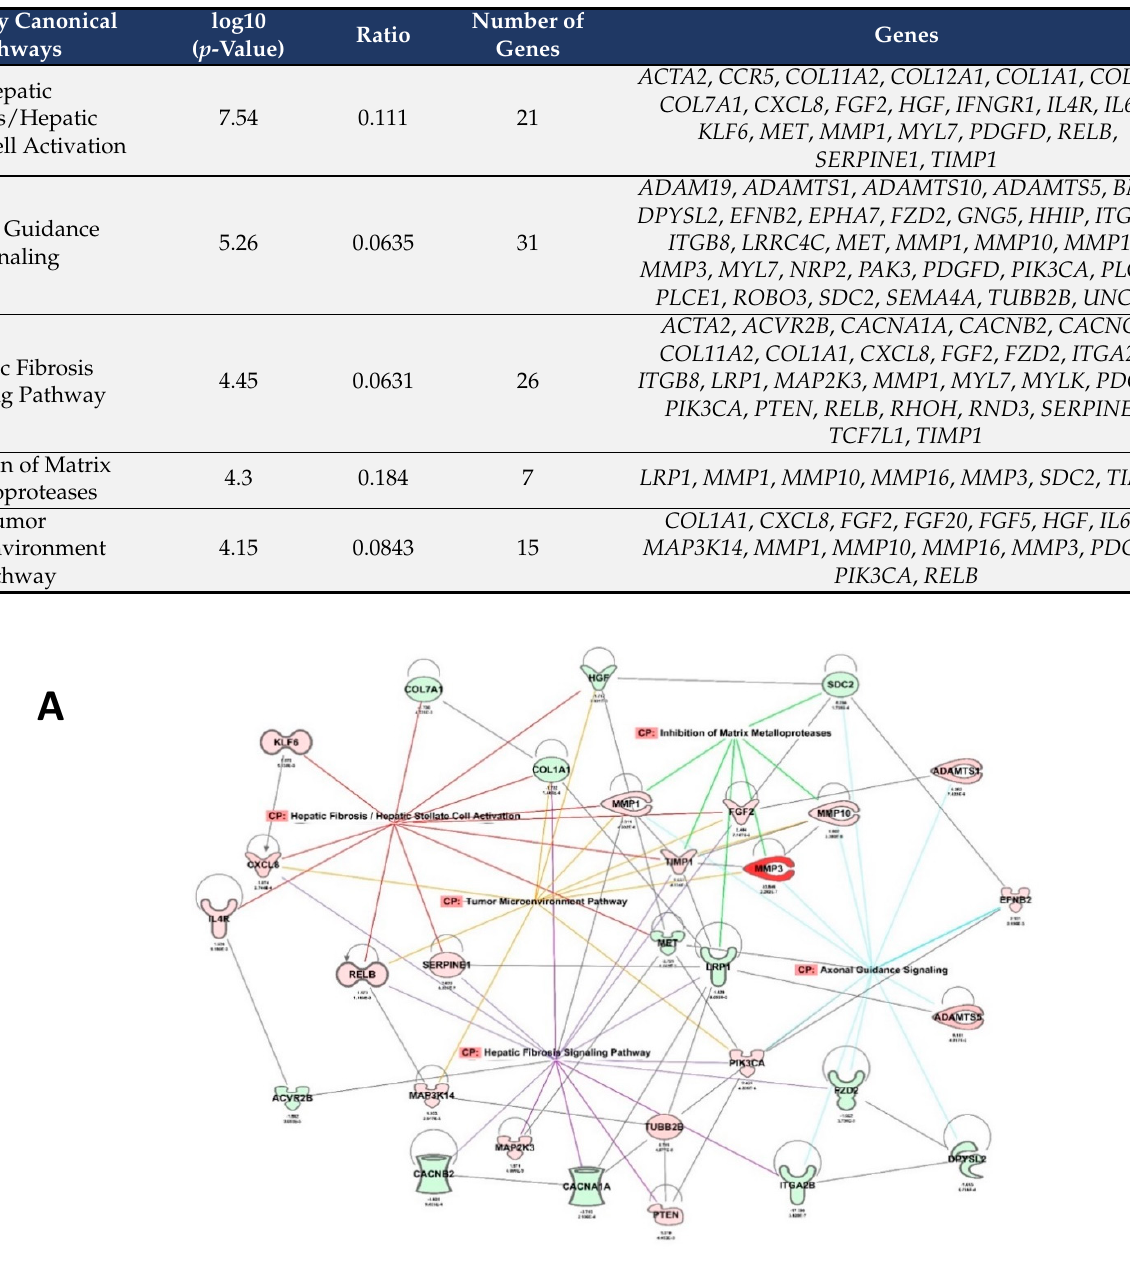
Table 2. Top five canonical pathways generated with the 655 significant deregulated RNAs in RBPMS SG2 vs. EV clones.